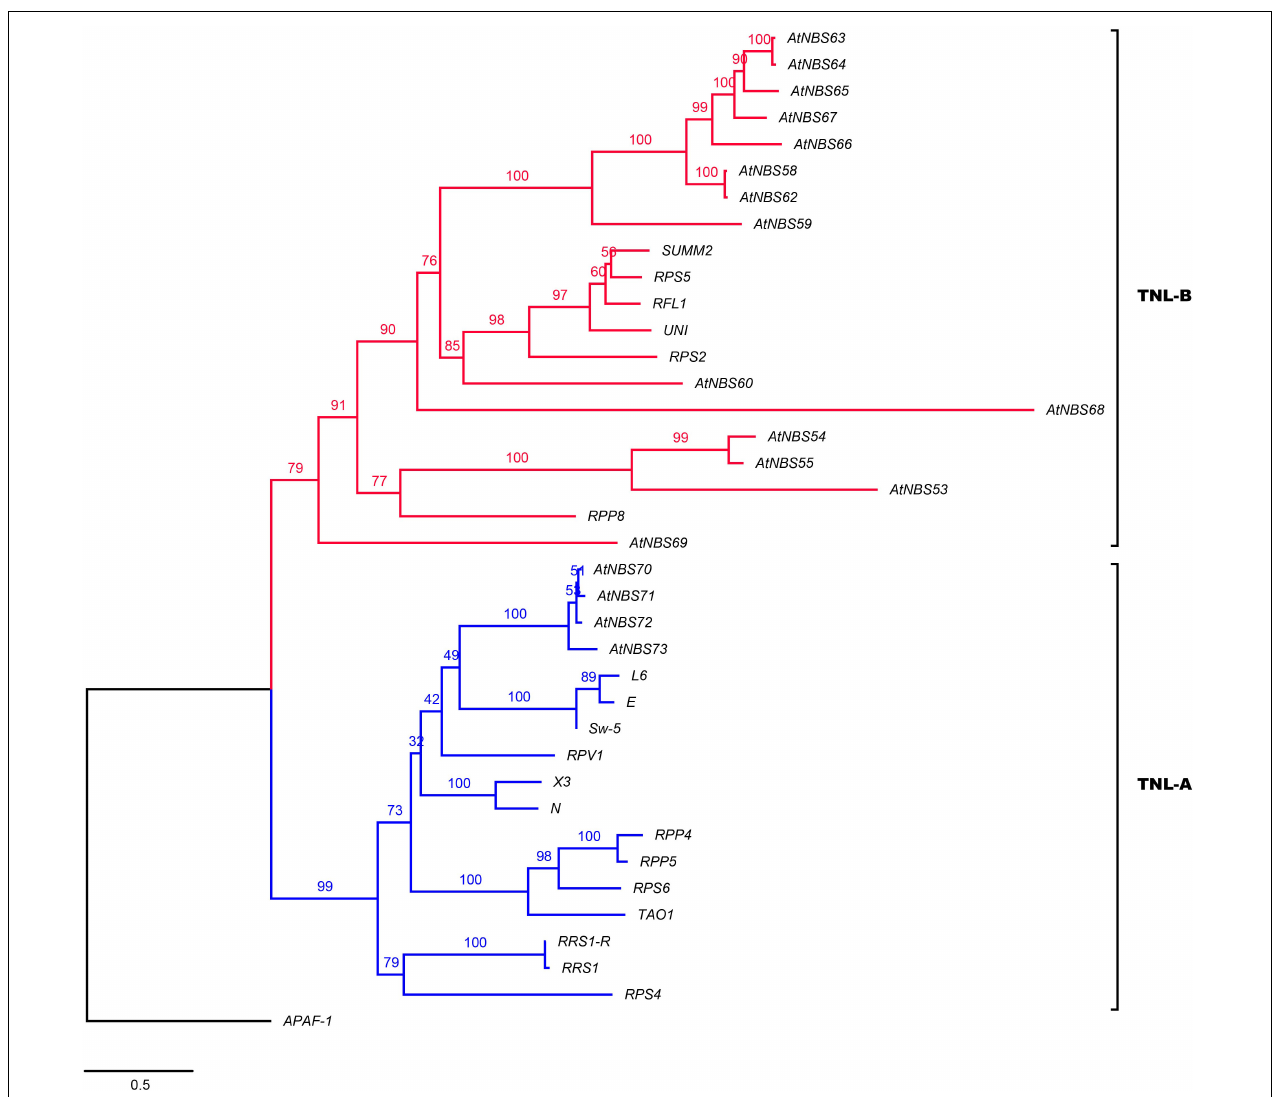
FIGURE 4 | Phylogeny of the TNL subclass of A. trifoliata NBS proteins with functional resistance genes from other species. Blue and red represent the TNL-A and TNL-B clades.